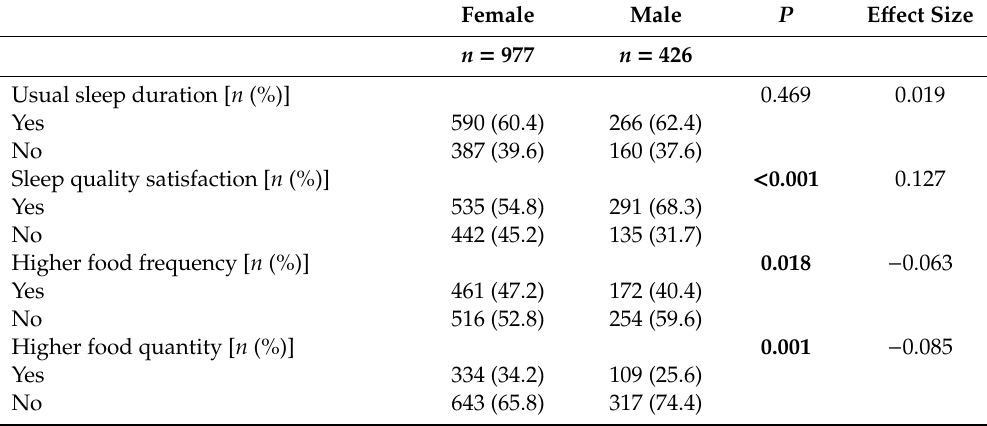
Table 2. Gender-related distribution according to sample characteristics ( n =